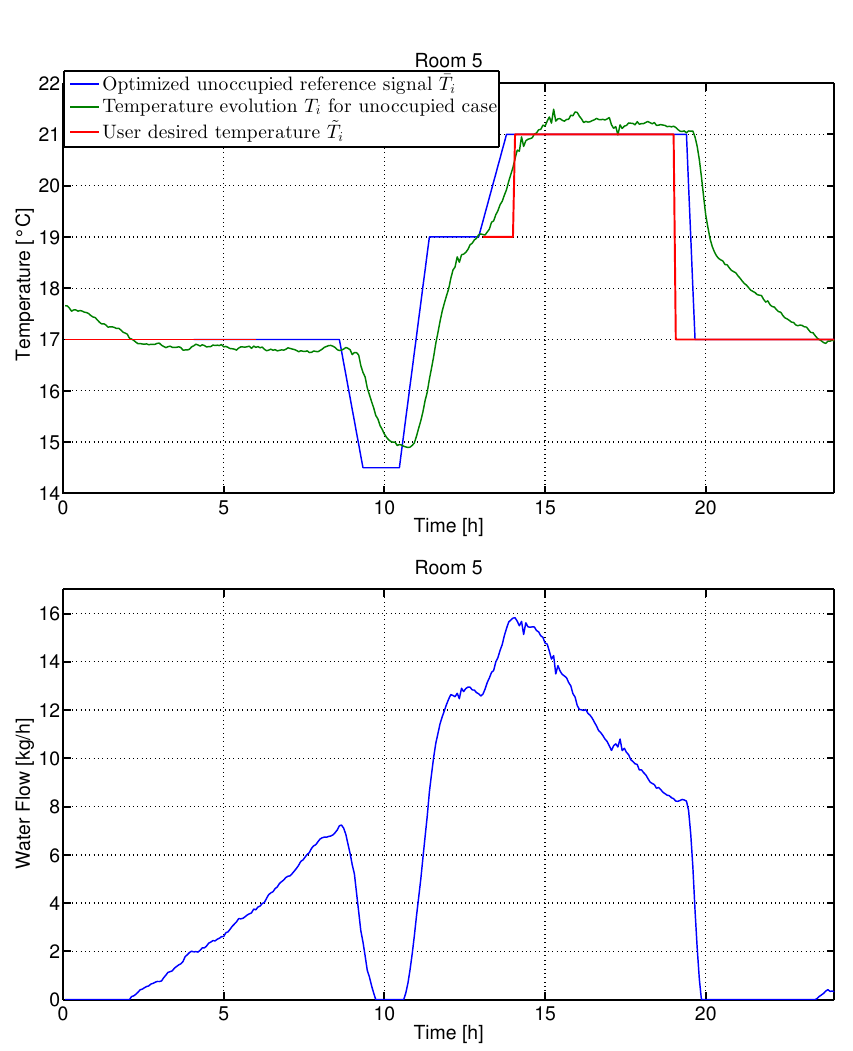
Figure 12. One day simulation, 5 December, for room 5 with radiators in case of no set-point given by the user (ARMAX